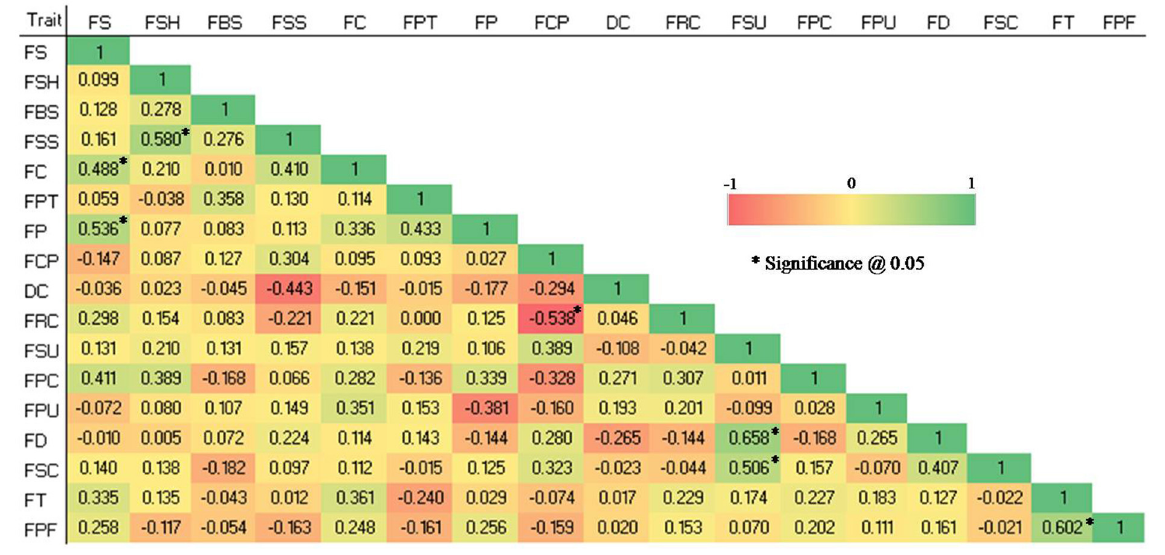
FIGURE2 Spearman correlation coefficient among 17 qualitative traits in 28 guava germplasm. FS, fruit size; FSH, fruit shape; FBS, fruit base shape; FSS, fruit shape at stalk end; FC, fruit cavity; FPT, fruit pulp texture; FP, fruit puffiness; FCP, fruit calyx persistence; DC, diameter of calyx concerning that of fruit; FRC, fruit ridged collar around calyx cavity; FSU, fruit surface; FPC, fruit peel color; FPU, fruit pulp color; FD, fruit dots; FSC, fruit surface covered by crimson or cherry red color; FT, fruit taste and FPF, pulp